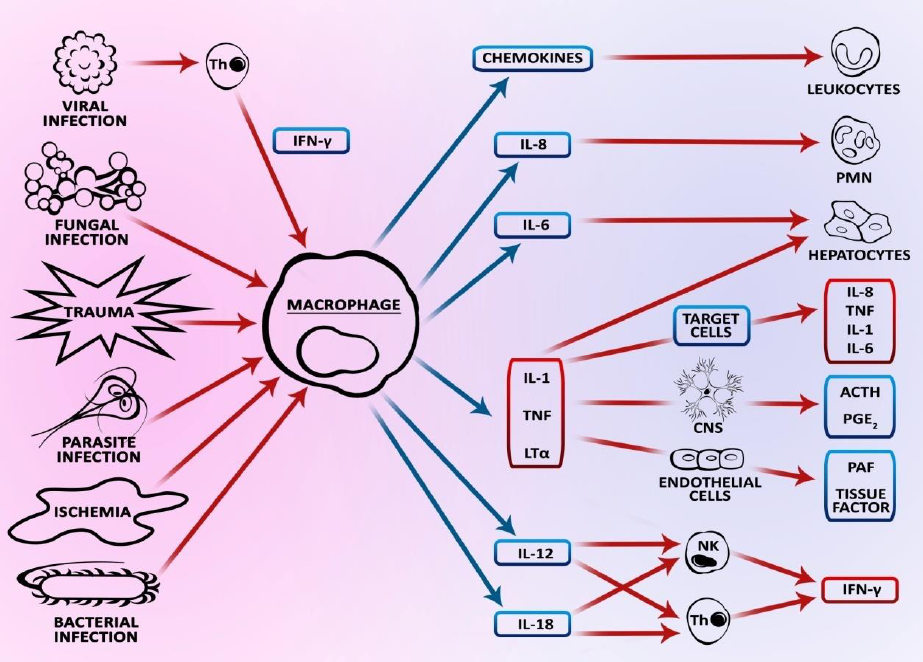
Figure 2. Relationships between cytokines.